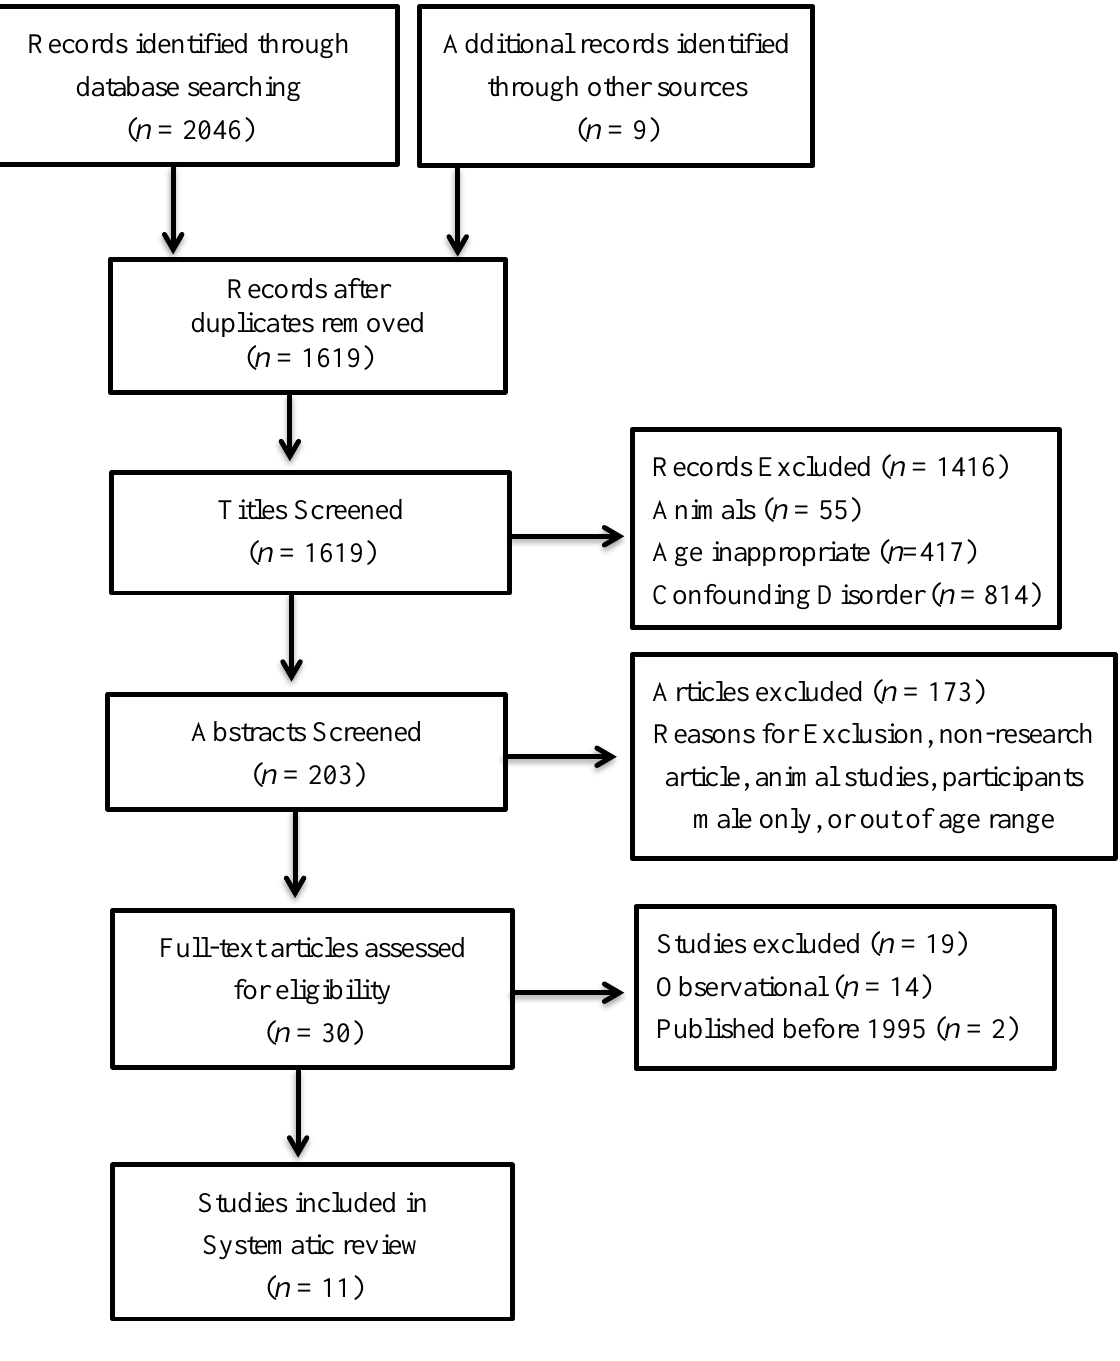
Figure 1. Flow chart of how the literature was selected for